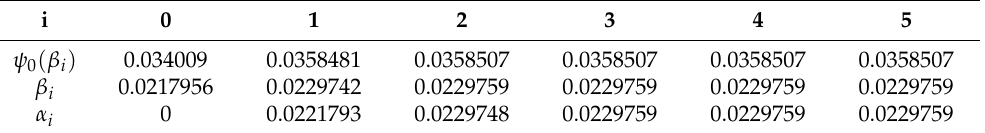
Table 4. Estimates for Example 4.